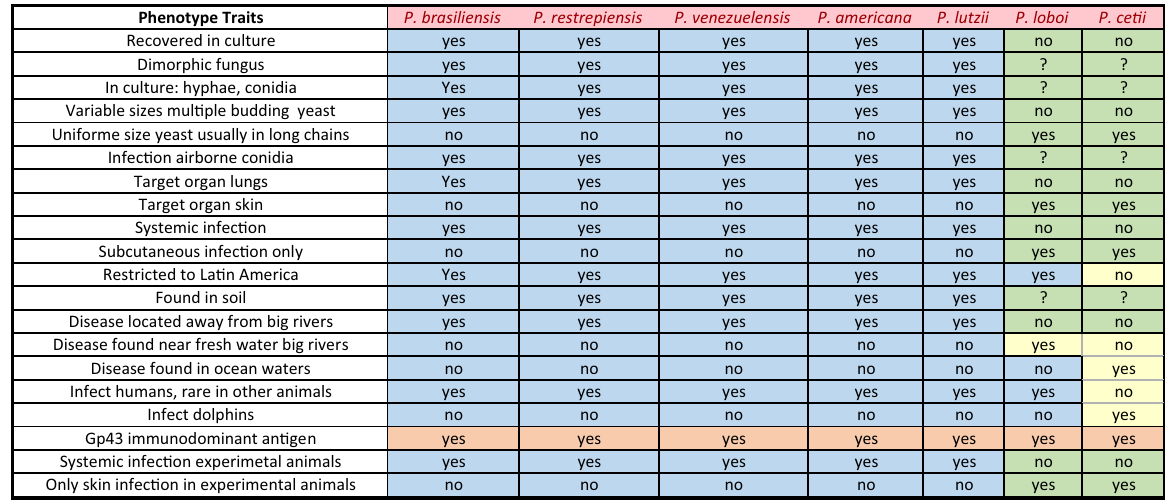
Table 1. Phenotypic traist of Paracoccidioides